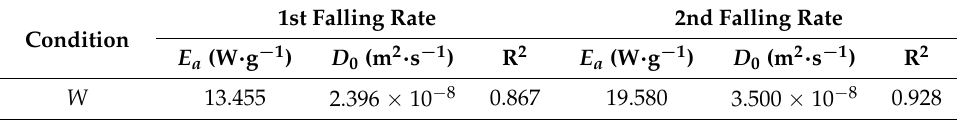
Table 10. Activation energy of lignite at different microwave power levels during microwave